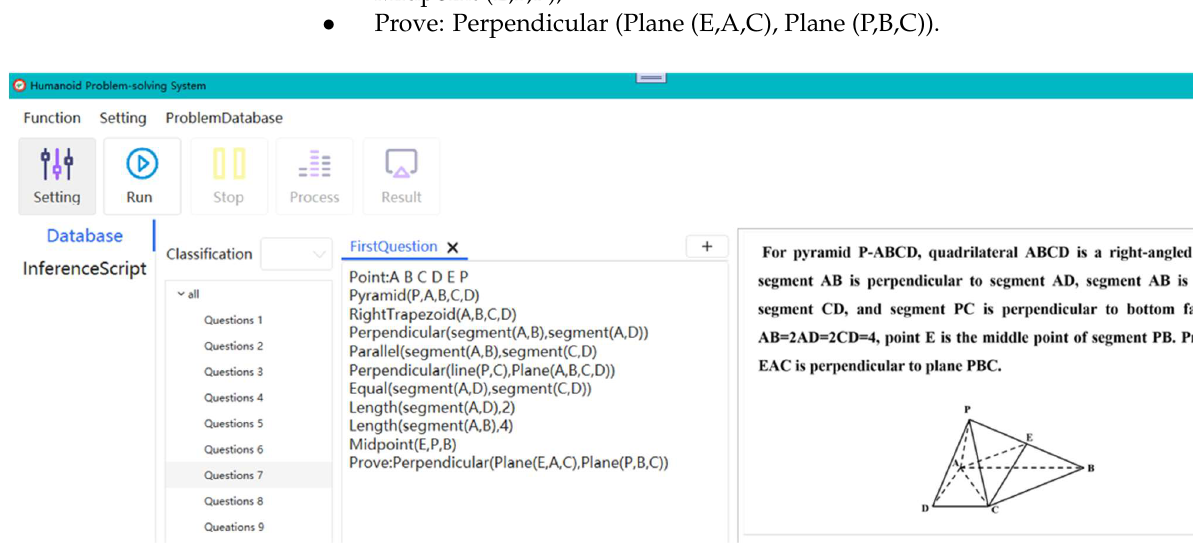
Figure 7. The operation interface of the automated geometry reasoning system.